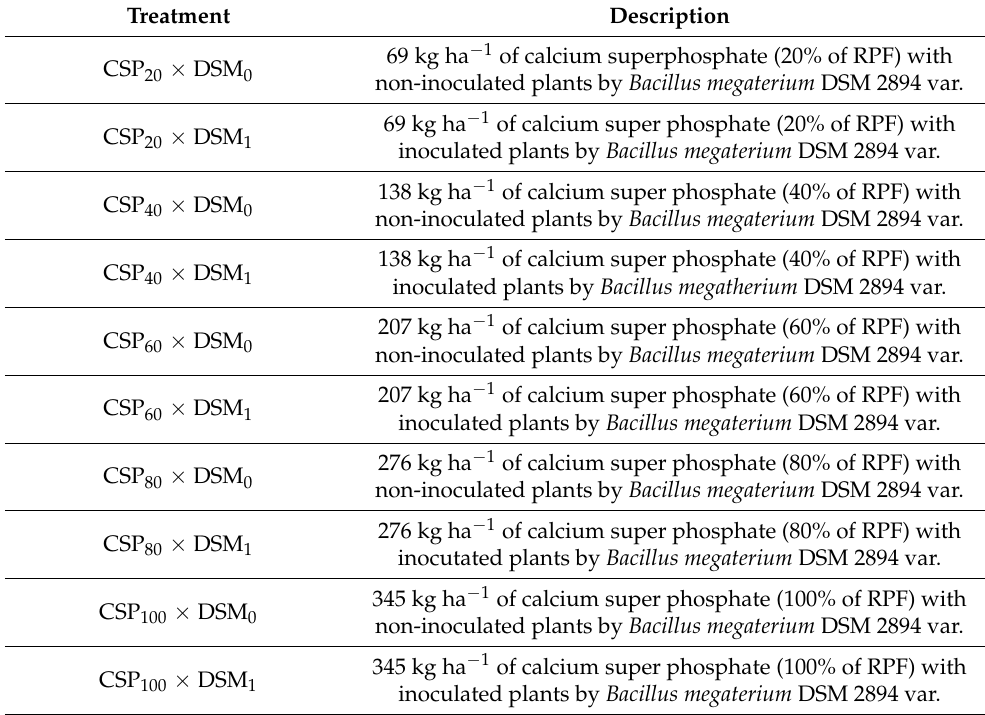
Table 3. The tested treatment in the